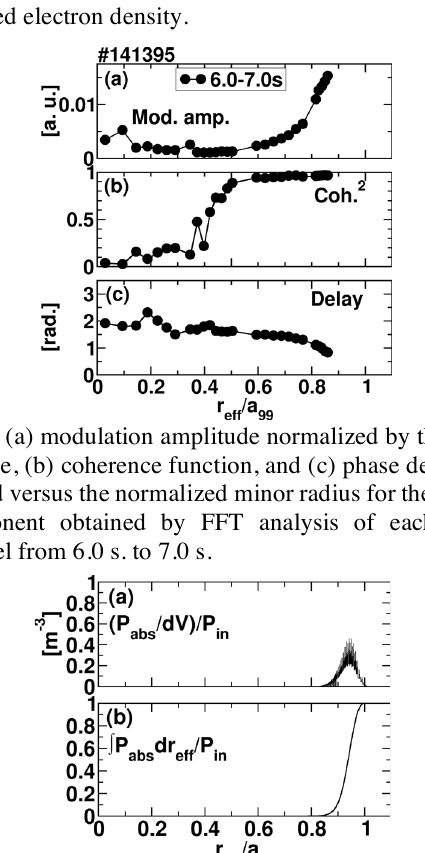
Fig.7 : Profiles of (a) local power absorption per unit volume and (b) integrated power absorption, plotted versus the normalized minor radius. These profiles are obtained by the ray tracing calculation with use of the fitted electron density profile shown in Fig. 4